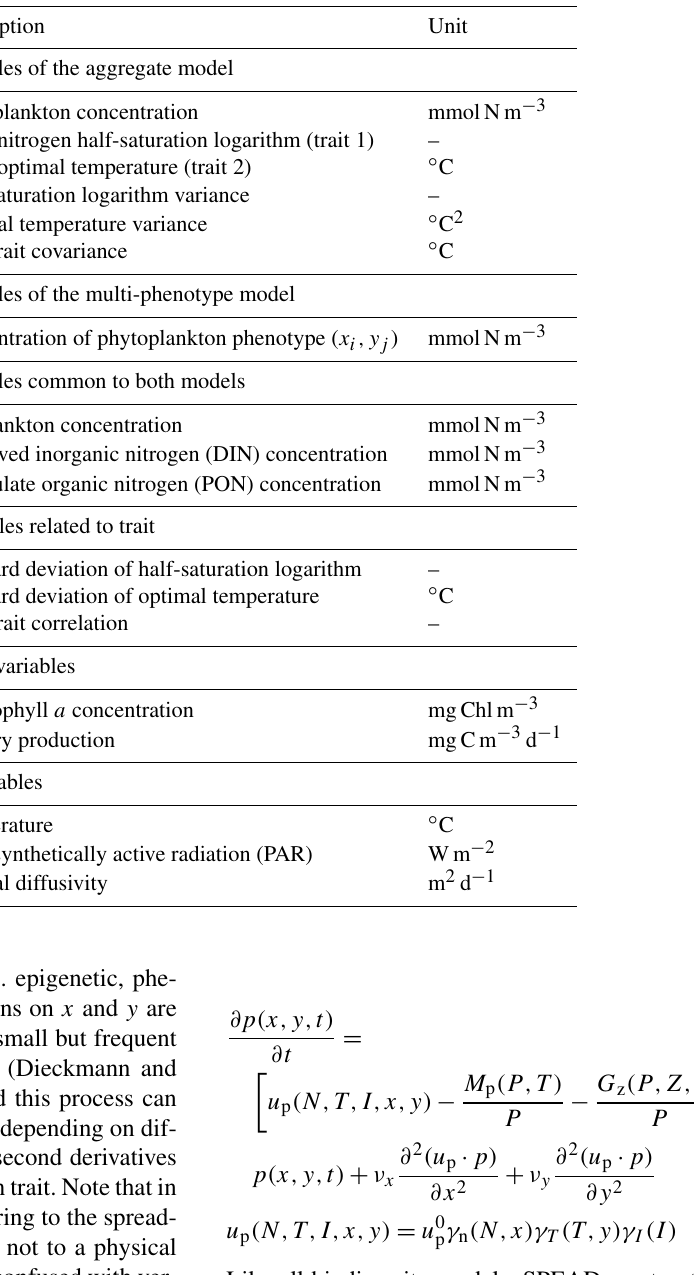
Table 1. State variables of the ecosystem